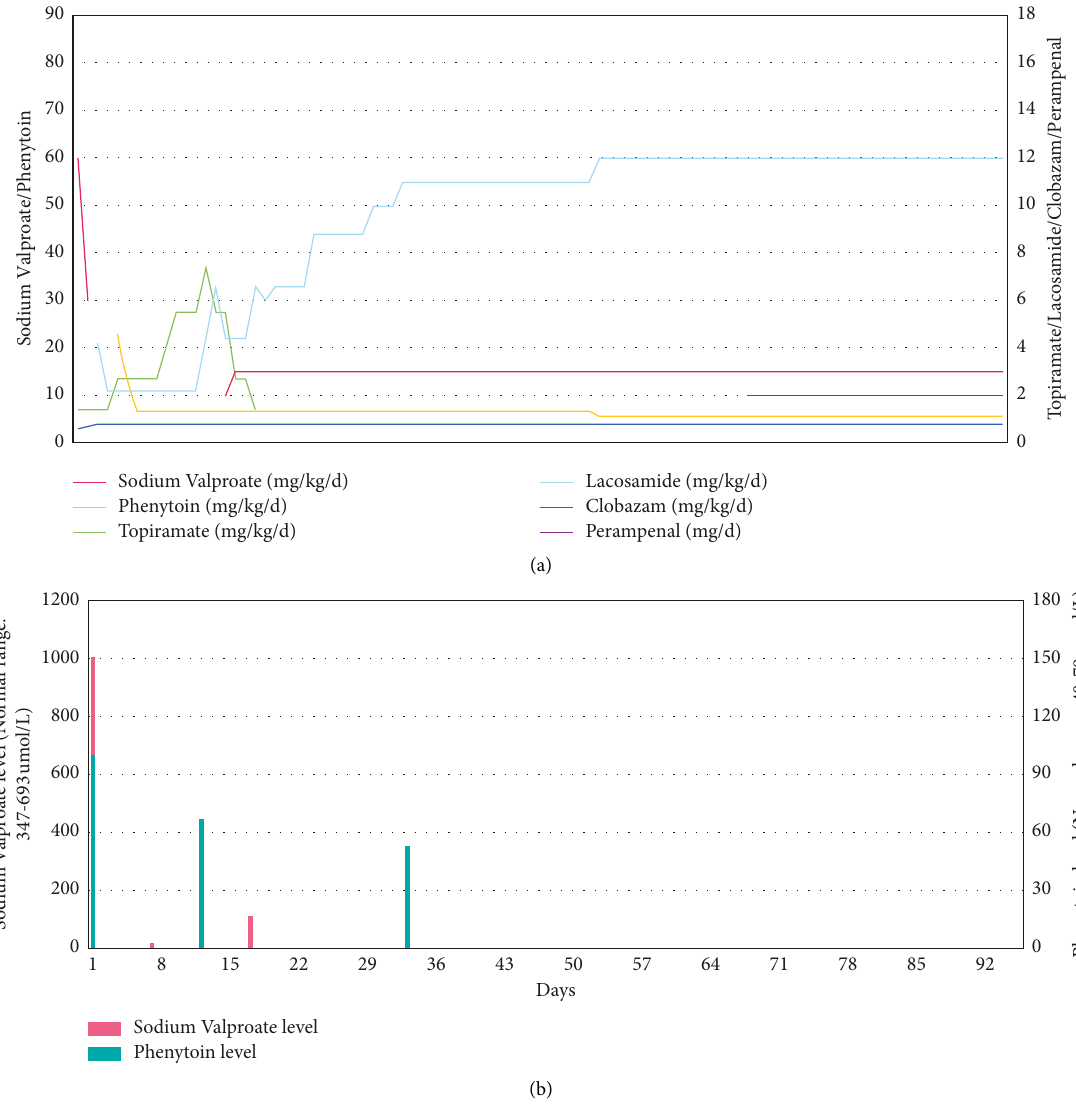
Figure 3: (a) Individual drug dosage over time. Sodium valproate (Epilim) and phenytoin dosage in mg/kg/d on the left. Topiramate, lacosamide, clobazam dosage, and perampanel level in mg/kg on the right. (b) Serum drug level over time. Sodium valproate (umol/L) in red. Phenytoin level (umol/L) in